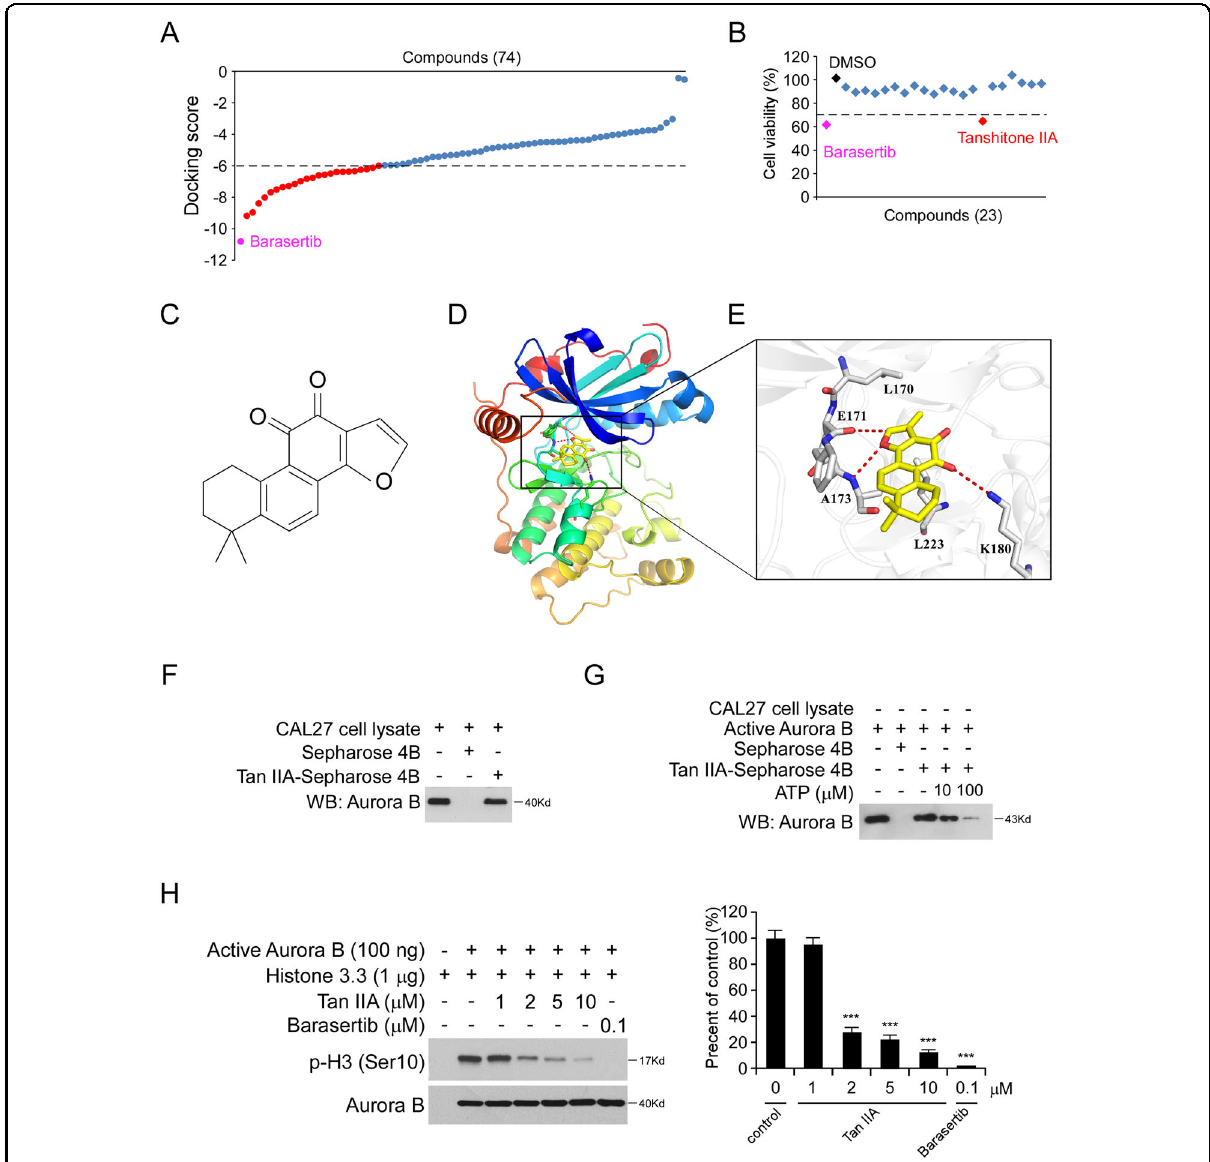
Fig. 2 Tan IIA is an Aurora B kinase inhibitor. A The docking scores of the screened natural products. Barasertib was used as a positive control. Pink, Barasertib; red, the 23 nature products with a docking score less than − 6. B MTS assay analysis of the cell viability of CAL27 cells with the 23 nature products treatment. C The chemical structure of Tanshinone IIA (Tan IIA). D The cartoon representation of the Tan IIA binding pocket in Aurora B. E Details of the binding mode of Tan IIA with Aurora B. The compound was shown as yellow sticks, while the proteins were depicted in cartoon representation with key residues labeled and demonstrated as gray sticks. Hydrogen bonds were shown as red dashed lines. F Tan IIA directly binds with Aurora B in CAL27 cells ex vivo. The ex vivo pull-down assay was performed as described in “ Material and methods ” , the beads were boiled and subjected to IB analysis. G The increase of ATP concentration inhibits the interaction between Tan IIA and Aurora B. H The in vitro kinase assay analyzes the effect of Tan IIA on Aurora B kinase activity. Barasertib was used as a positive control; n = 3 independent biological replications, one-way ANOVA; *** p <